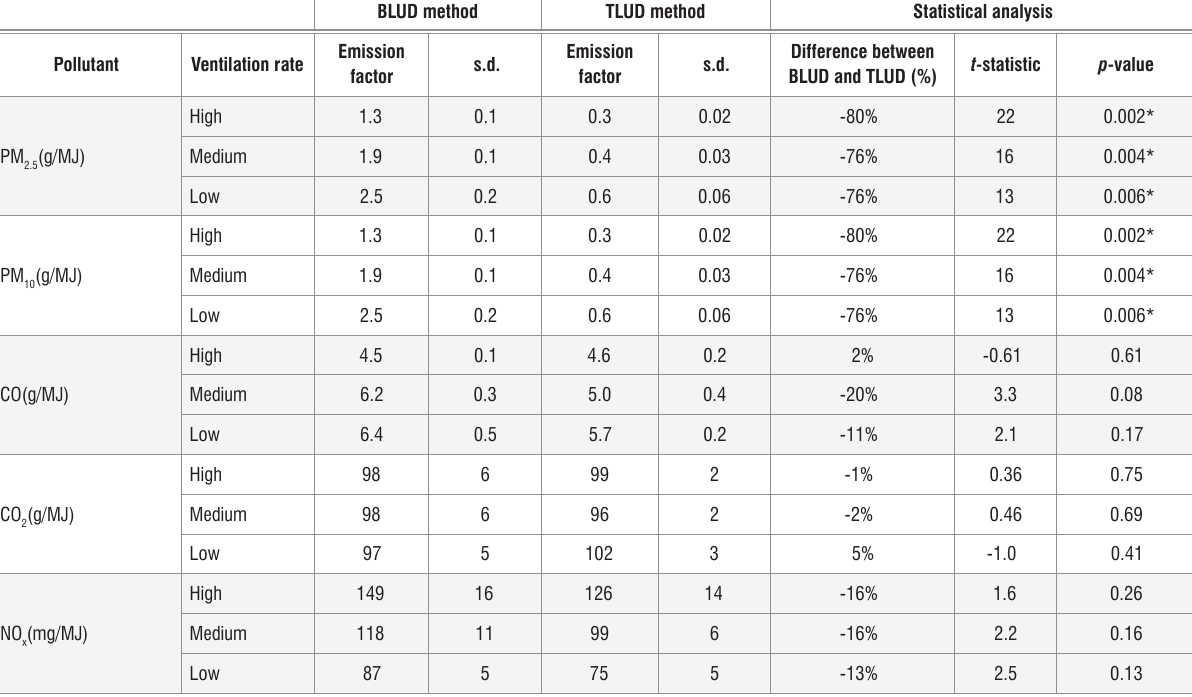
Particulate matter (PM) and gas emission factors for the lab-designed coal braziers using D-grade coal, for the top-lit updraft (TLUD) and bottom- lit updraft (BLUD) ignition methods at low, medium and high ventilation rates ( n